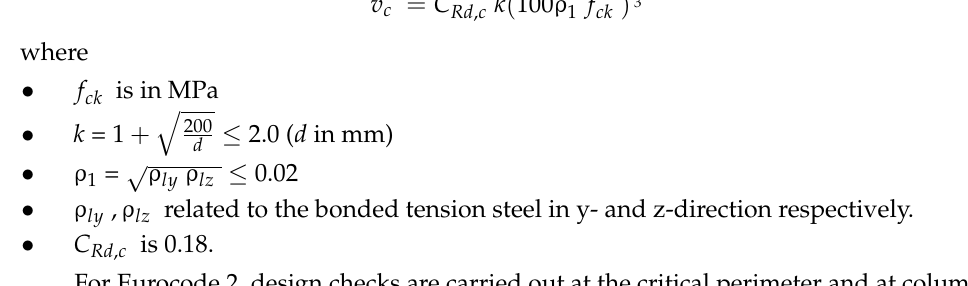
shown in Equation (2)